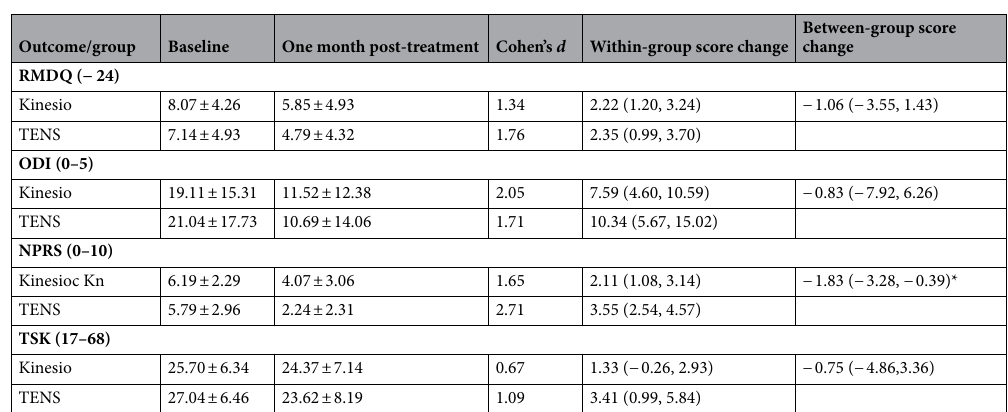
Between-group score change